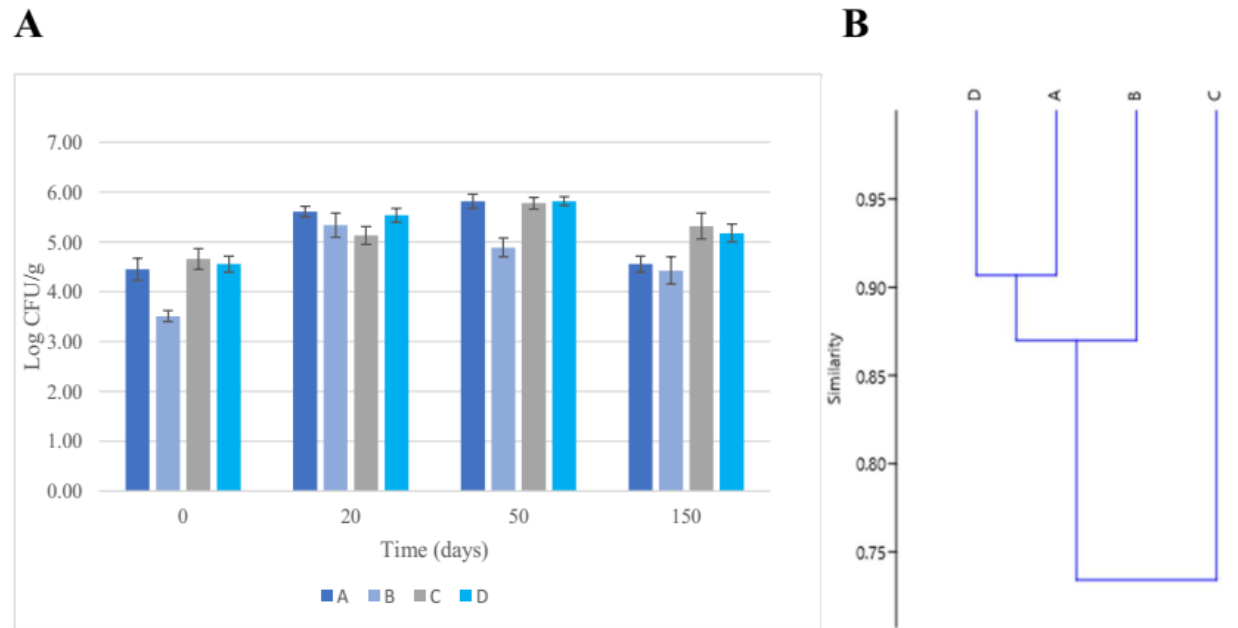
Figure 1. CNS evolution in Ventricina del Vastese sausage of four manufacturers A, B, C and D (A) and correlation among the evolution trends for the different manufacturers (B).